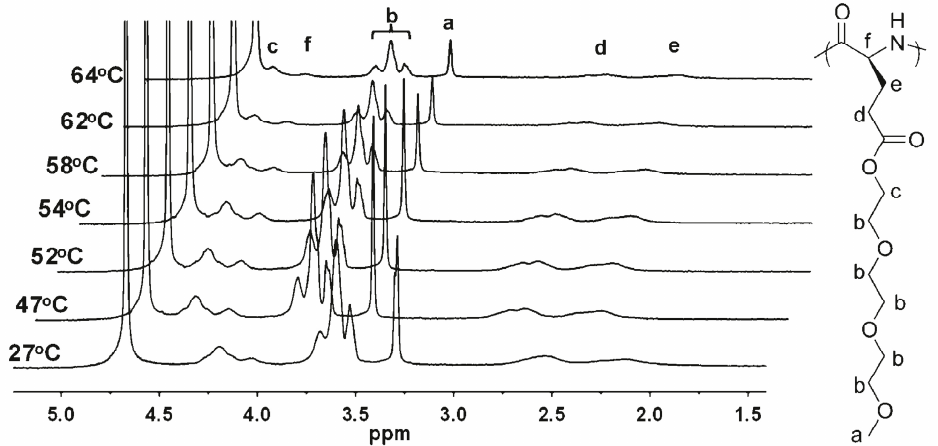
Figure 5. 1 H NMR spectra of poly- L -EG 3 Glu as a function of temperature in D 2 O. Reproduced with permission [34]. Copyright 2011, American Chemical Society.